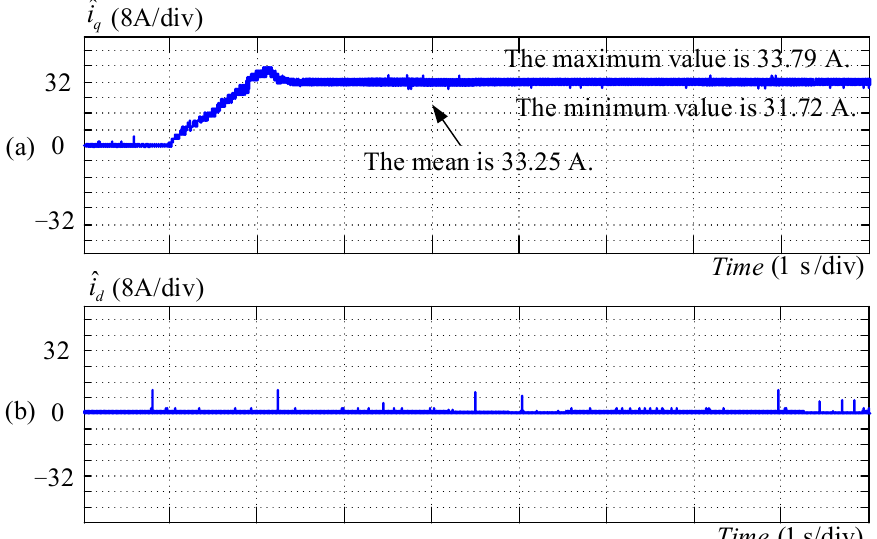
Figure 11. Measured q-axis and d-axis currents of a three-phase permanent-magnet synchronous motor driven at 1500 rpm with compensation strategy for harmonic components in induced EMF along the a-axis, b-axis, and c-axis: ( a ) measured ˆ i r q ; ( b ) measured ˆ i r